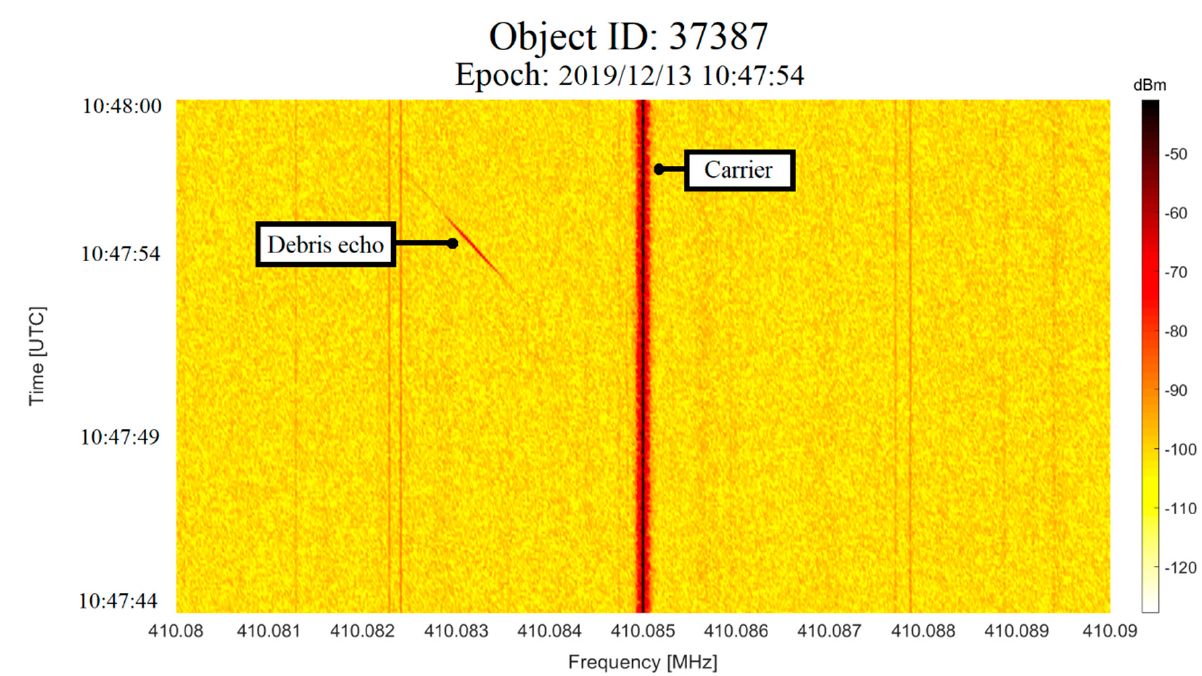
Electronics 2021 , 10 , x FOR PEER REVIEW 16 of 20